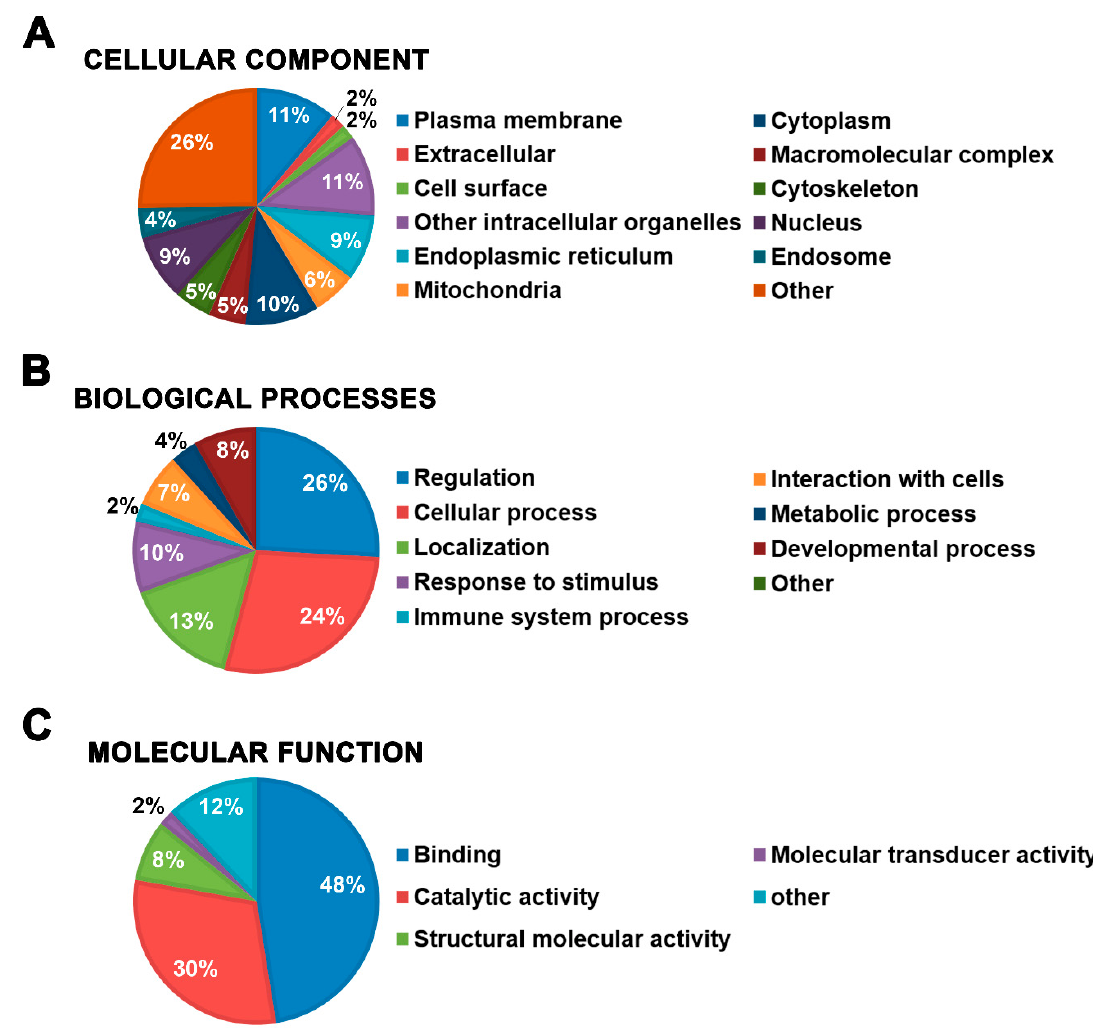
Figure 5. Graphical representation of the GO classes of biological domains association data with the 949 proteins identified in mast cell lipid rafts as annotated by STRAP. Identified proteins were grouped according to the three main GO classes: ( A ) cellular component, ( B ) biological processes, and ( C ) molecular function. The data is expressed as a percentage of proteins associated with each GO term.